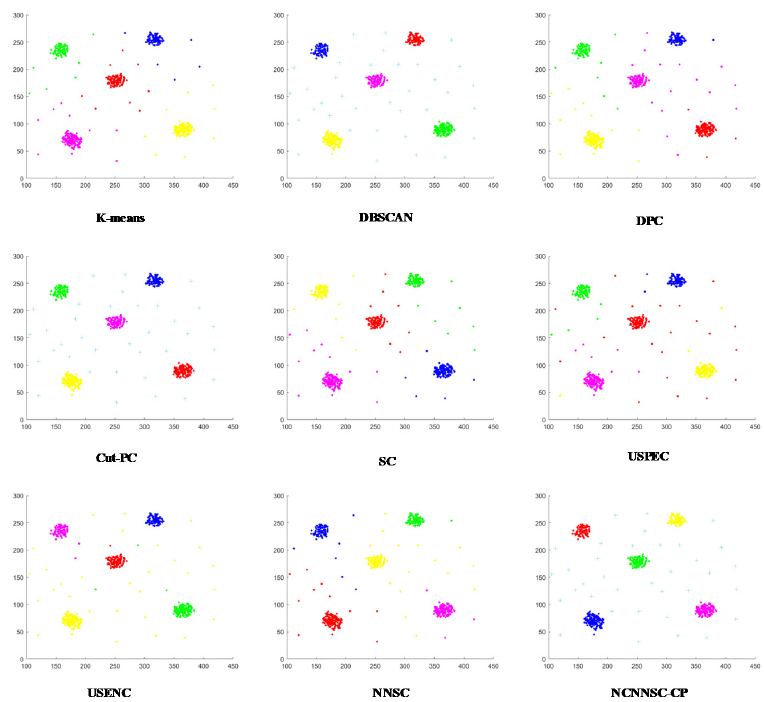
Figure 6. The results of 9 clustering algorithms in D1.